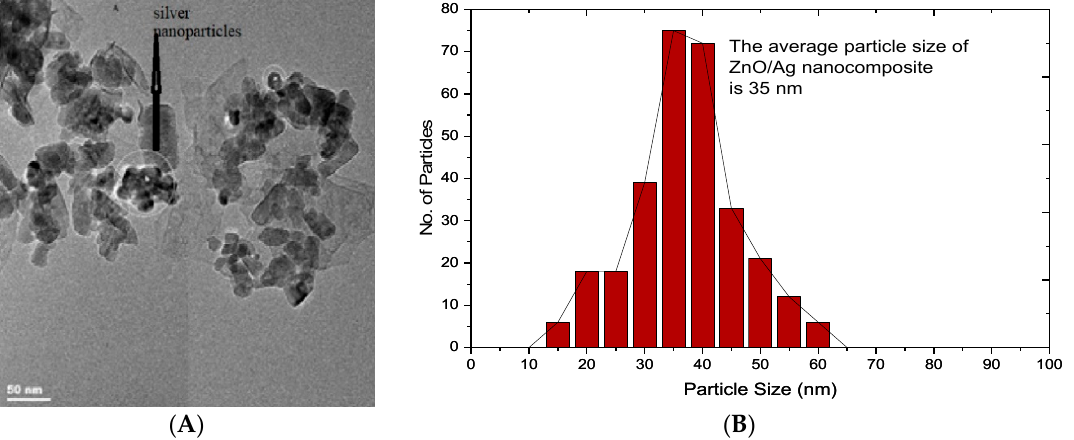
Figure 5. ( A ) TEM micrograph of ZnO/Ag ( B ) Particle size distribution of ZnO/Ag nanocomposite adapted from reference [19].